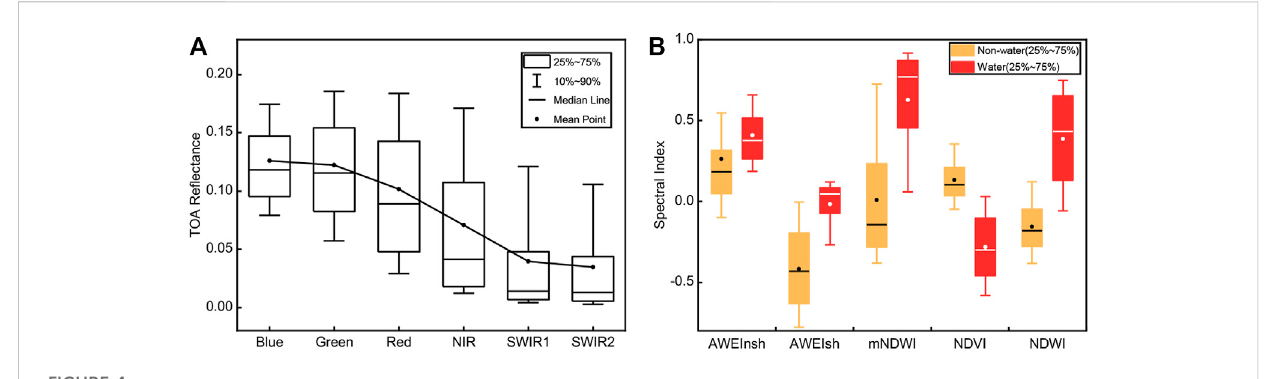
FIGURE 4 Sample features statistics. (A) Spectral features; (B) spectral index features.